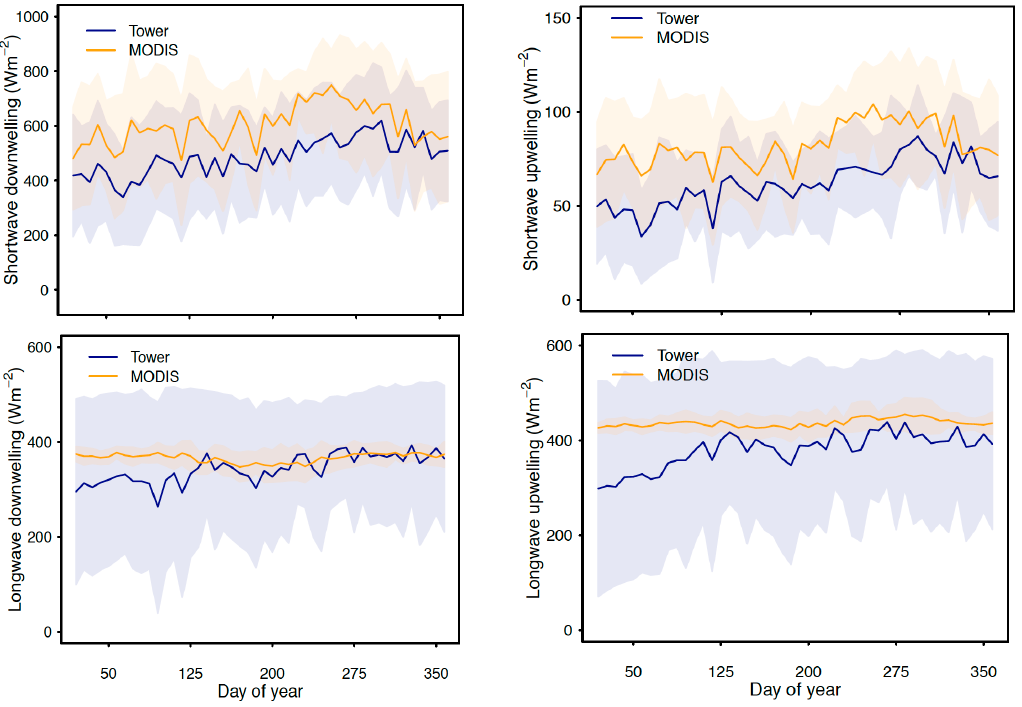
Figure 11. Comparison between the four components of net-radiation from MODIS and corresponding measurements at Terra overpass time at 7 tropical sites. Note that the Y -axis scales are different in different subplots.